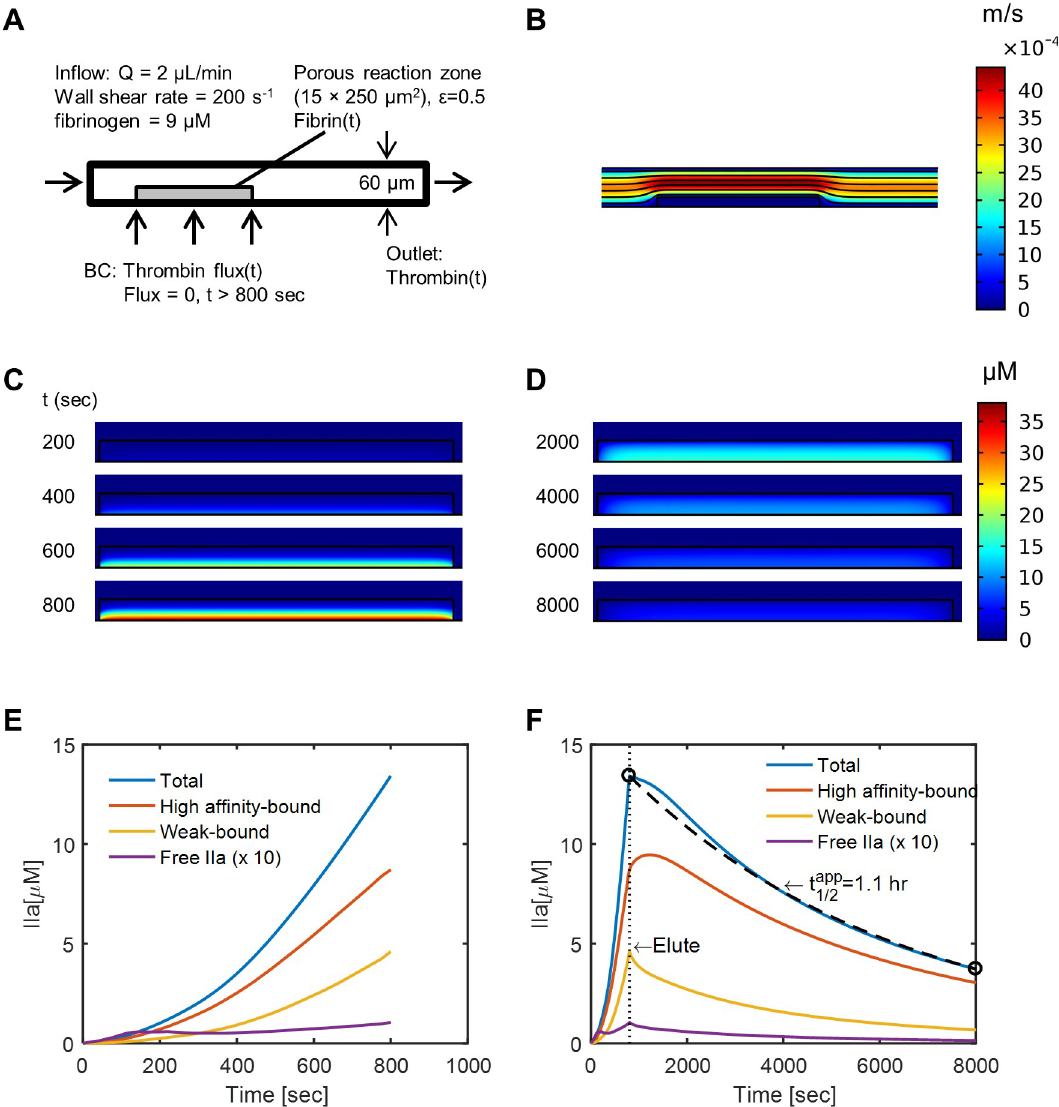
Fig 5. Transient convection-diffusion of thrombin into and out of a fibrin domain exposed to venous flow. The 2D simulation domain and imposed boundary conditions (A) allowed determination of the velocity field (B) and the intrathrombin thrombin transport dynamics over time (C, D). The average concentration of total, free, and bound thrombin in the clot domain are shown for imposed thrombin flux and fibrin concentrations (E). After 800 sec, no fresh thrombin was delivered into the clot and the elution of thrombin from the clot domain was followed